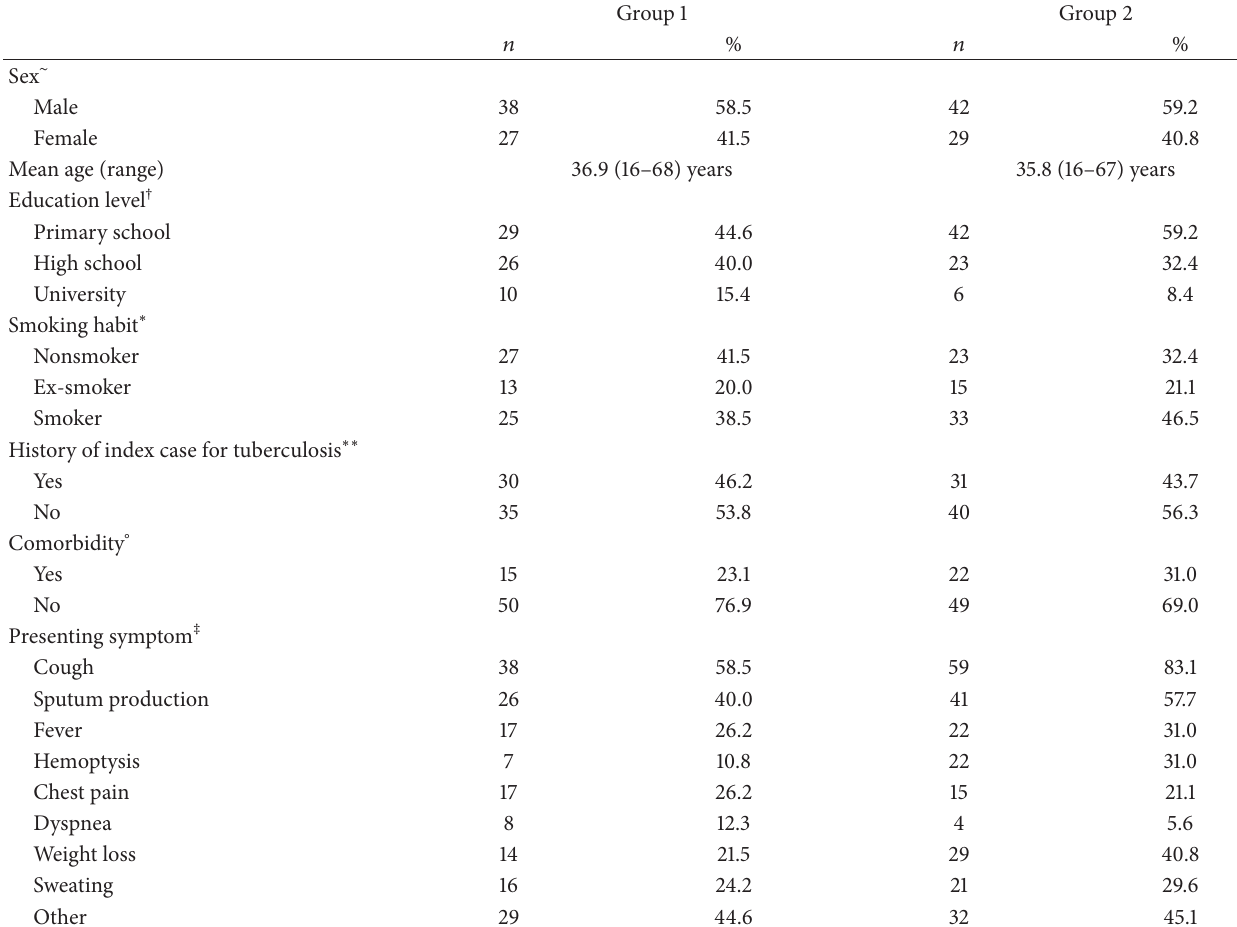
Table 1: Demographic characteristics of the study population.